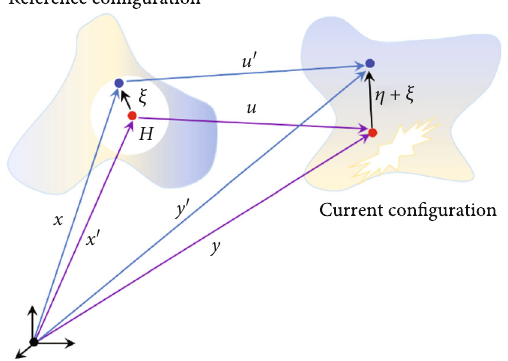
Figure 1: The motion of a peridynamic continuum body.